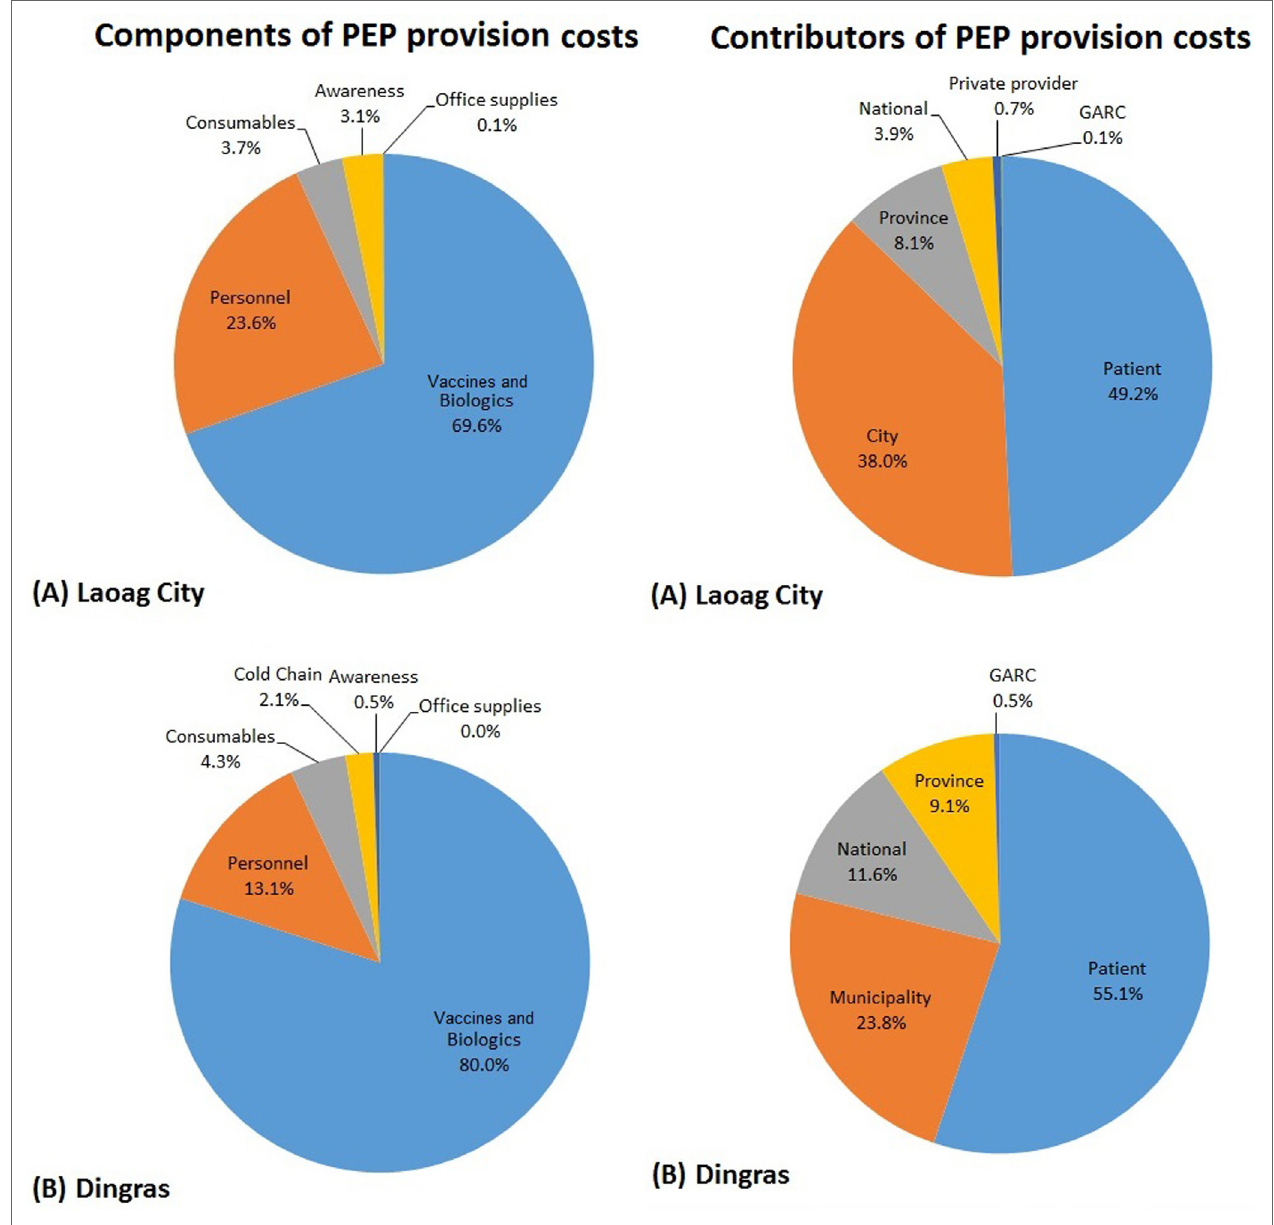
FigUre 2 | The cost of providing postexposure prophylaxis (PeP) divided into the different components and between the different project contributors for (a) laoag city and (B) Dingras Municipality from 2012 to 2014